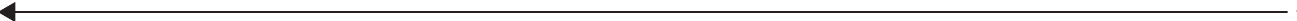
Fig. 4 Numerical image analysis of mitochondria changes in H 2 O 2 -exposed cells. Fine structural changes of mitochondria in HEI-OC1 cells were numerically analyzed. Cells were dyed with MitoTracker Orange mitochondrial fl uorescence and captured with confocal microscopy. b Different types of fusion and fi ssion mechanisms involving process-speci fi c kinds of network nodes (tip-to-tip, tip-to-side or side-to-side). Graph representation of the mitochondrial reticulum using four node types: 1 ( magenta ), 2 ( green ), 3 ( dark blue ), and 4 ( blue ). The reticulum can be represented as a set of linear segments consisting of one or more edges ( black rods ) liking the nodes. b Control cells ( upper panel ) and H 2 O 2 - exposed cells ( lower panel ) with bandpass fi lter and Skeletonize plugin on ImageJ. Skeleton ( left panel ) shows that the red images are band- pass fi ltered image, and the green lines show the fi ltered and skeletonized image. Analysis ( right panel ) shows the connection between tip and side. The natural logarithm ln(x) of raw parameter + 1 was used because the parameter ’ s distribution was closed to log-normal distribution. The natural logarithm of branch count c , branching point d and average branch length e showed a signi fi cant decrease in the H 2 O 2 -exposed cells compared to the control cells ( P < 0.05). Descriptor variables are shown in Supplementary Table